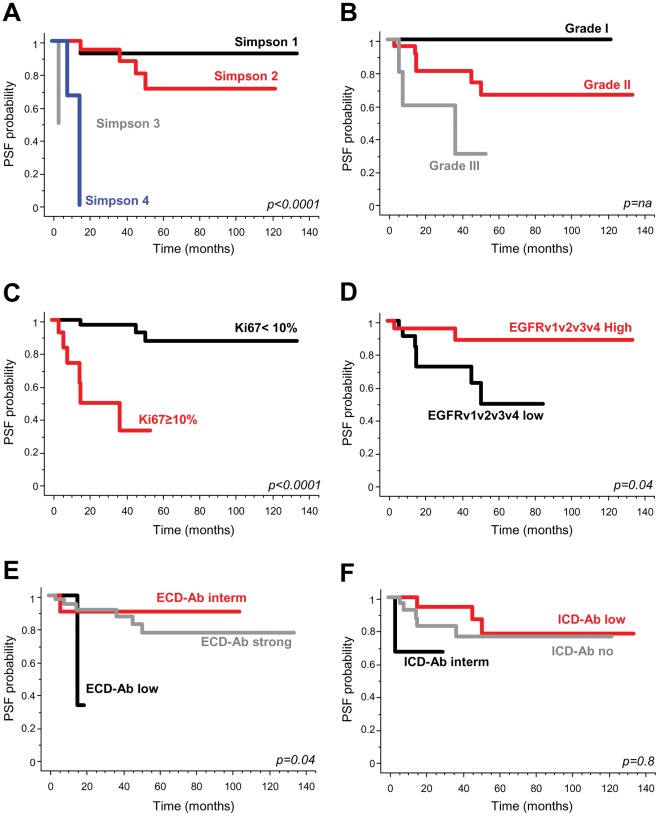
Patient PFS according to clinical and biological parameters.Probability of progression free durvival (PFS) was expressed in months, according to Simpson grade (A), histological tumor grade (B), Ki67 labeling index (C), EGFRv1v2v3v4 mRNA levels (D), ECD-Ab labeling (E), and ICD-Ab labeling (F).